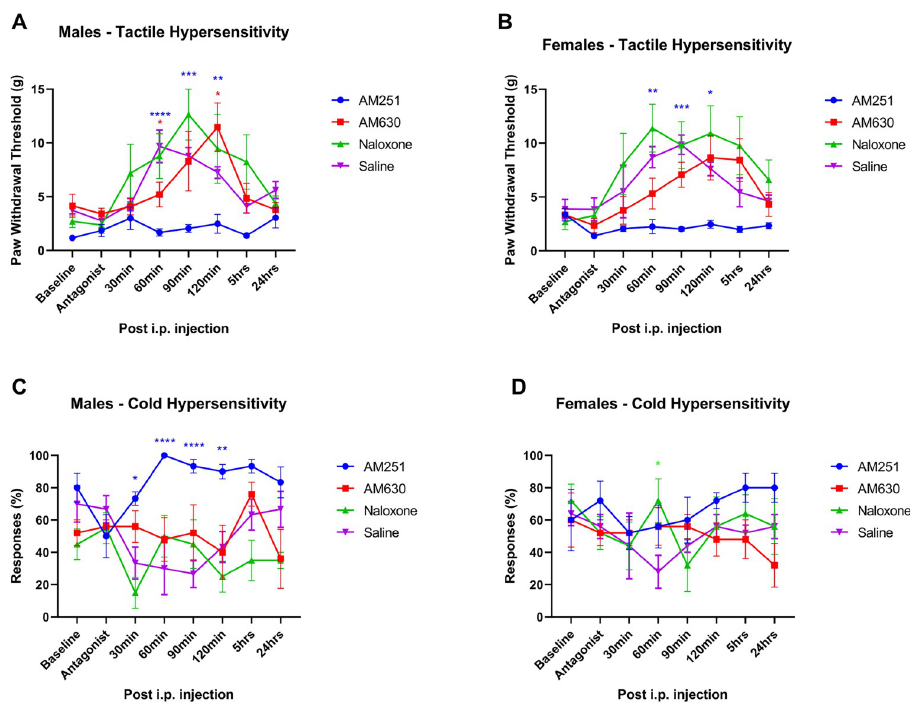
Fig 9. Effect of selective antagonists on the antinociceptive effects of CBD and BCP combination. Time plots of the antinociceptive effects of combined CBD (0.5, 1.5 mg/kg) and BCP (10, 15 mg/kg) following antagonist administration: AM251 (3 mg/kg), AM630 (1 mg/kg) or mu-opiod receptor antagonist naloxone (5 mg/kg) on mechanical PWT in A) males and B)females, and acetone responses in C) males and D) females, respectively (n = 5 per treatment group). Animals received a subcutaneous injection of the antagonist or saline 30 min prior to CBD/BCP administration in SCI rats. � , �� , ��� , ���� denote p < 0.05, 0.01, 0.001 and 0.0001 (color coded), compared to vehicle for each treatment